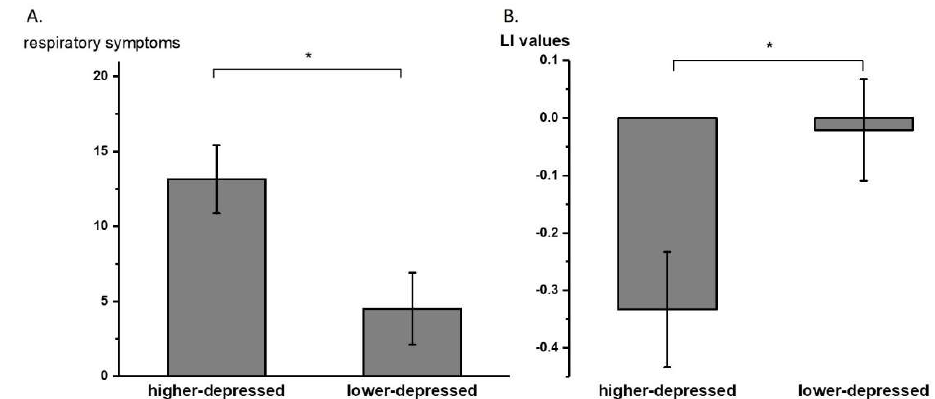
Figure 4. ( A ) Averaged ( ± SE) respiratory symptom questionnaire total scores of higher- and lower- depressed subgroups. ( B ) Averaged ( ± SE) laterality index (LI) values of higher- and lower-depressed groups with average split. * p < 0.05.